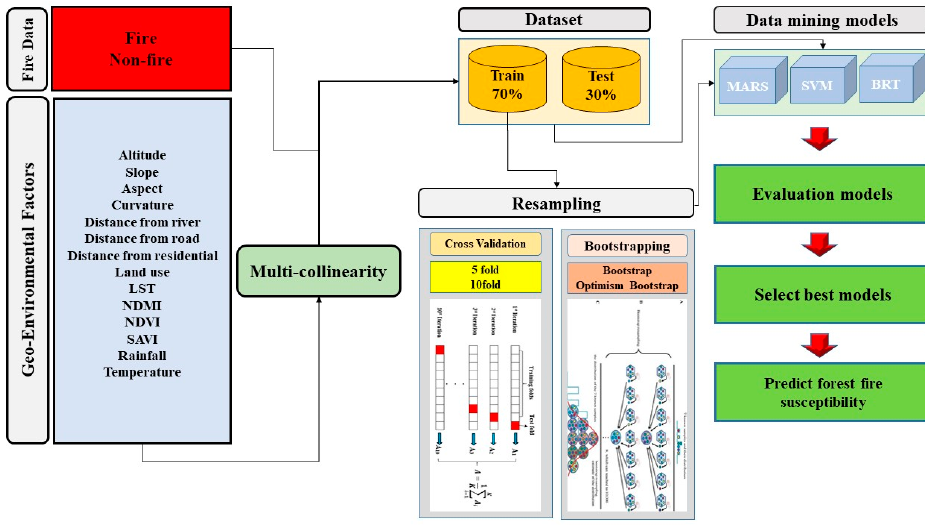
Figure 2. Framework of the proposed methodology.